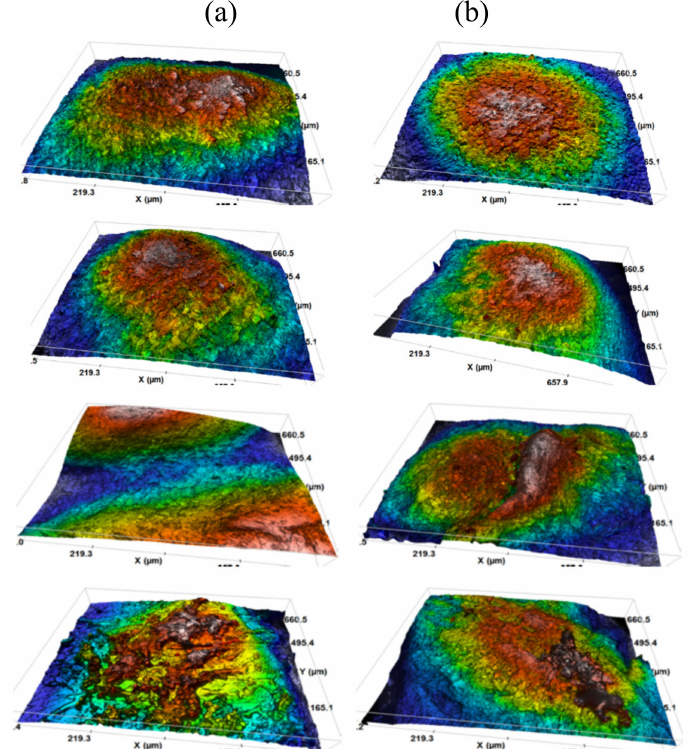
Figure 8. Confocal optical microscopy micrographs of the nail surfaces of some volunteers. ( a ) Treated nails, ( b ) untreated nails.